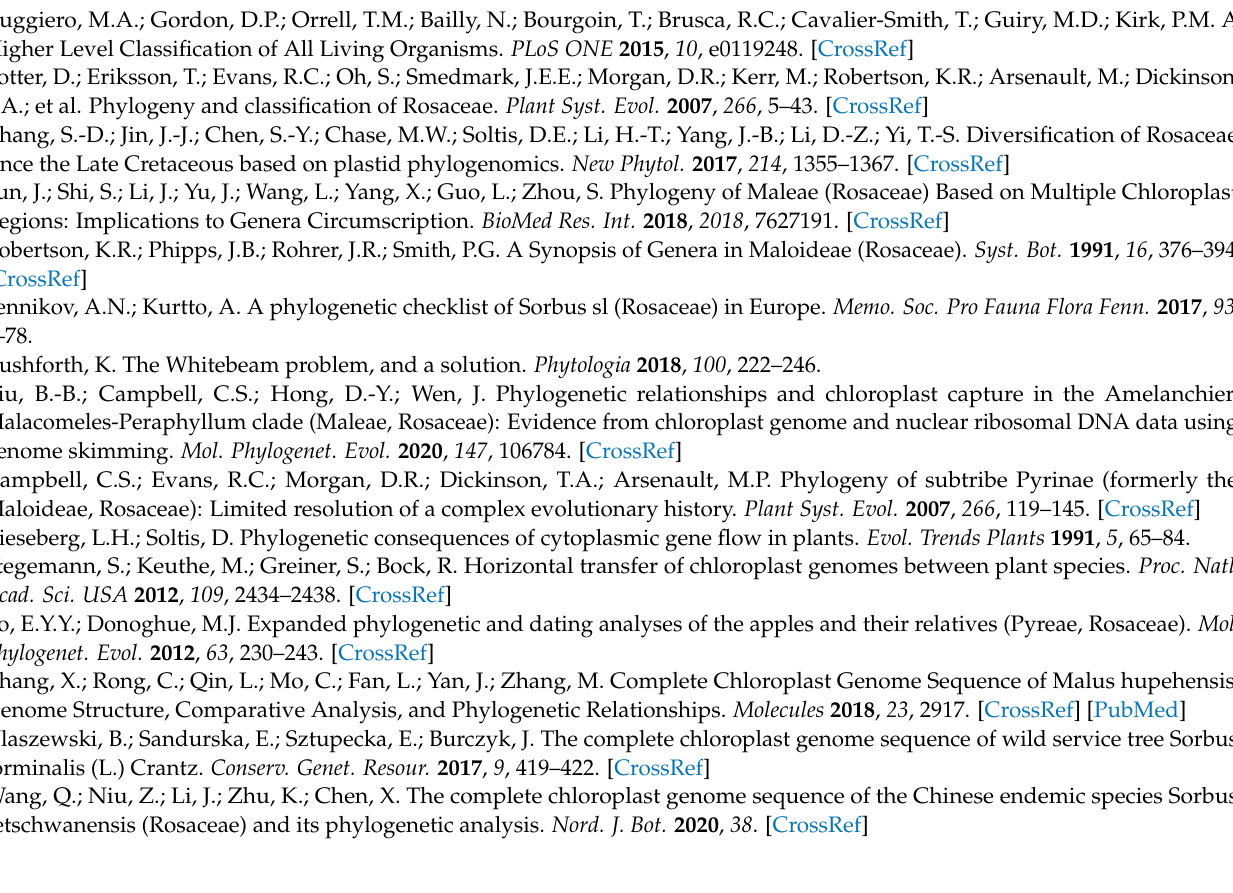
Table S2. Comparison of chloroplast assemblies of S. aucuparia, T. glaberrima, A. edulis, and C. alpina. Table S3. List of names of species included in the phylogenetic analyses. Table S4. Genetic distances among 110 taxa inferred based on complete chloroplast genomes. Figure S1. Synteny comparisons of chloroplast genomes: Sorbus aucuparia (1), Torminalis glaberrima (2), Aria edulis (3) and Chamaemespilus alpina (4). The chloroplast genome of Sorbus aucuparia was used as the reference sequence. Within each of the alignments, local collinear blocks were marked by the same color and connected by lines. Figure S2. About 50-year-old individual of Sorbus aucuparia L. sampled in this study, located in Tryszczyn Forest Nursery, Poland (53.171761 N, 17.941530